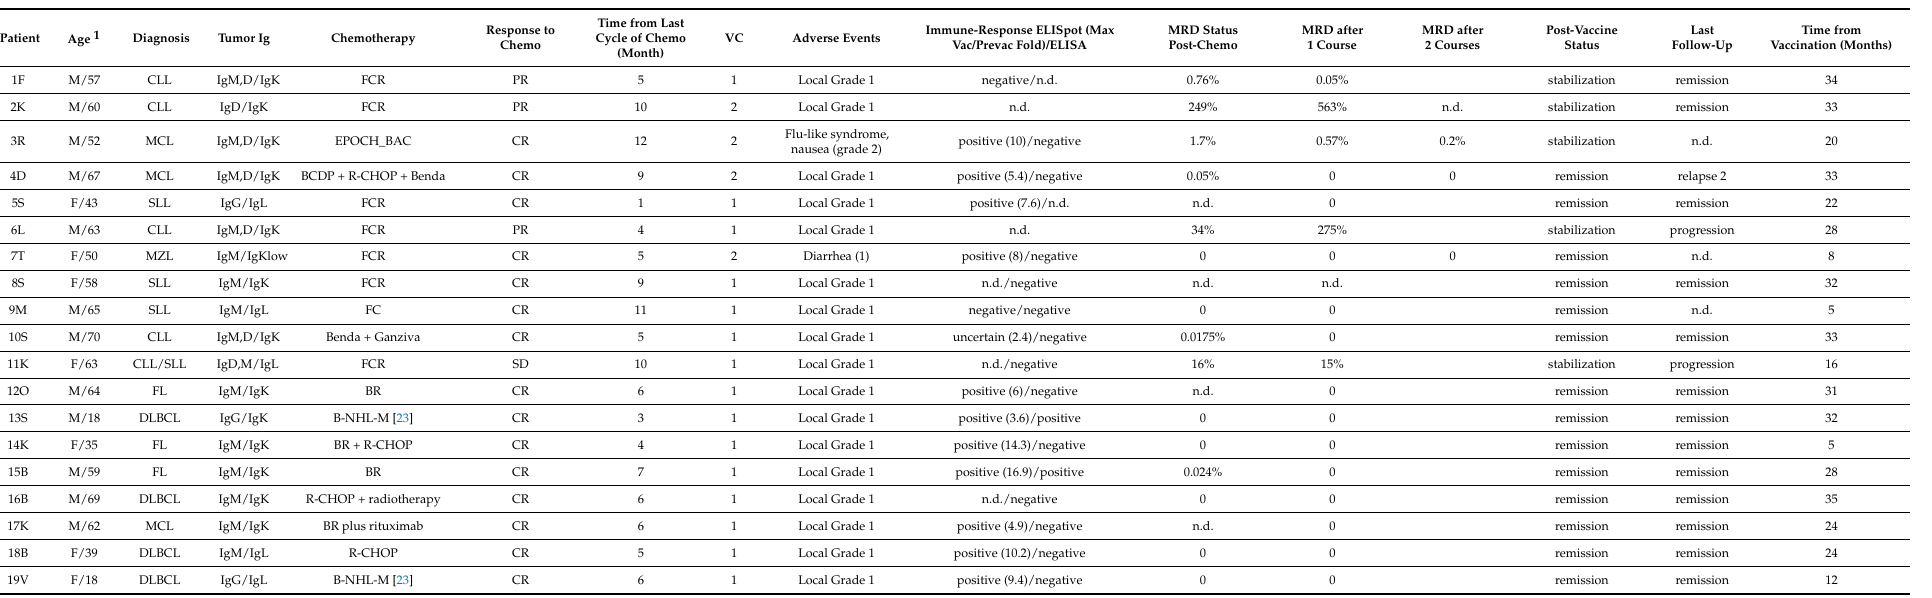
Table 1. Results of treatment and vaccination of the